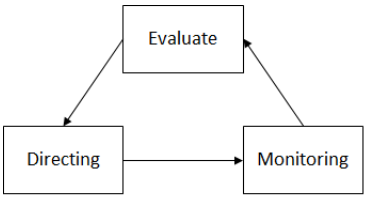
Figure 1. ICT governance tasks. Source: ISO/IEC 38500 2009